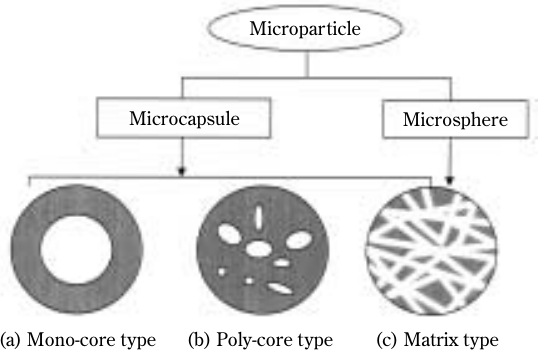
Fig. 1 Classification of microparticles from